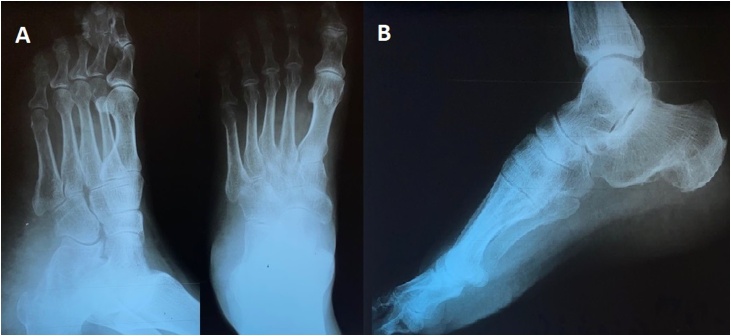
Plain radiograph: Anteroposterior views show soft tissue mass in plantar and heel of right foot (A), lateral view shows subcutaneous soft tissue mass in foot plantar and heel with slight calcaneus periosteal irregularity of calcaneus bone (B).